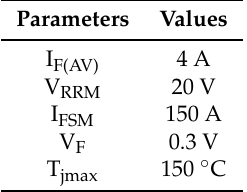
Table 3. Schottky diode